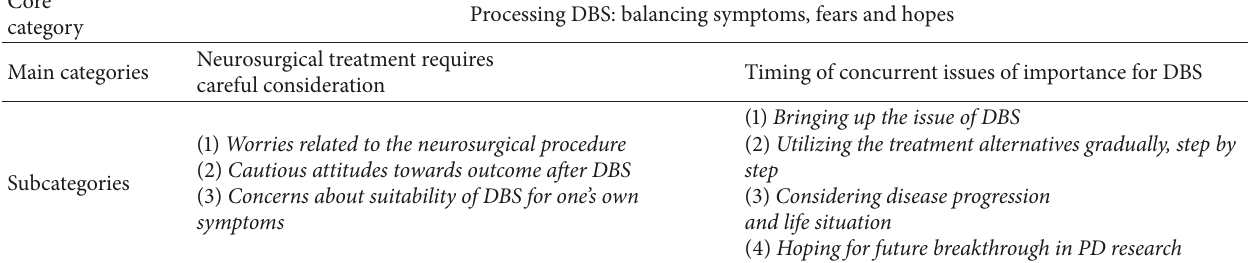
Table 2: A core category underpinned by two main categories. Each main category is supported by three and four subcategories, respectively.